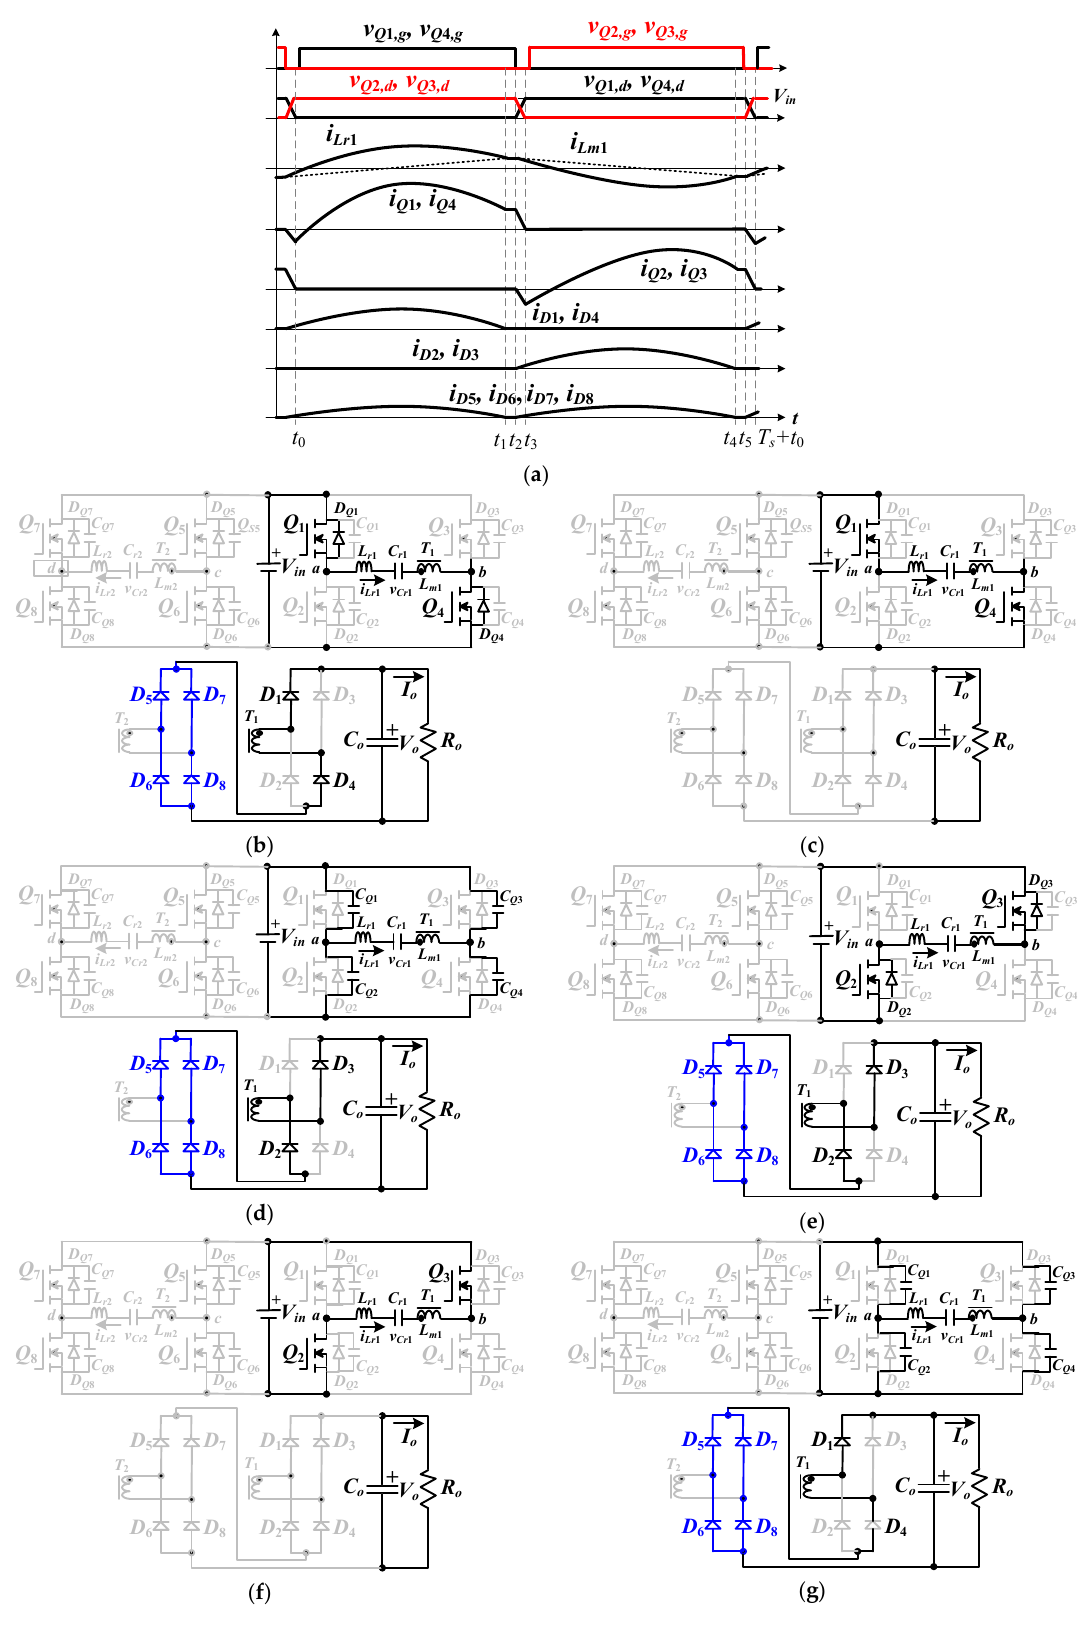
Figure 5. Circuit waveforms and equivalent circuits at high input voltage range and f s < f r, ( a ) PWM waveforms, ( b ) step 1, ( c ) step 2, ( d ) step 3, ( e ) step 4, ( f ) step 5, ( g ) step 6.